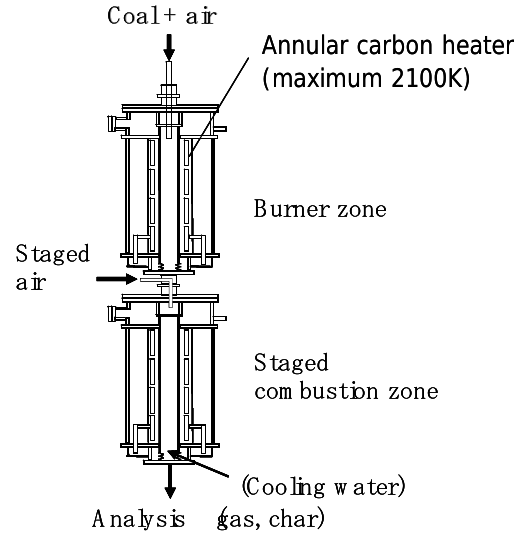
Figure 16. Structure of the drop-tube furnace for staged combustion.